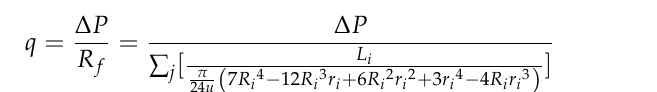
Table 6. Comparison between the experimental and theoretical values.